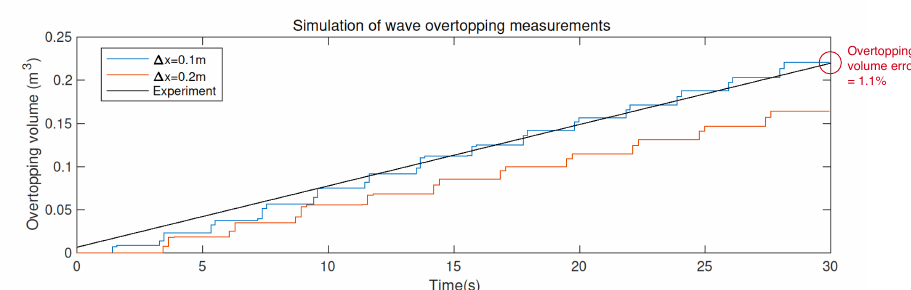
Figure 10. Comparison for the overtopping volume between REEF3D::SFLOW simulation and the experimental measurements. The total overtopping volume error is marked in the plot for the fine grid.